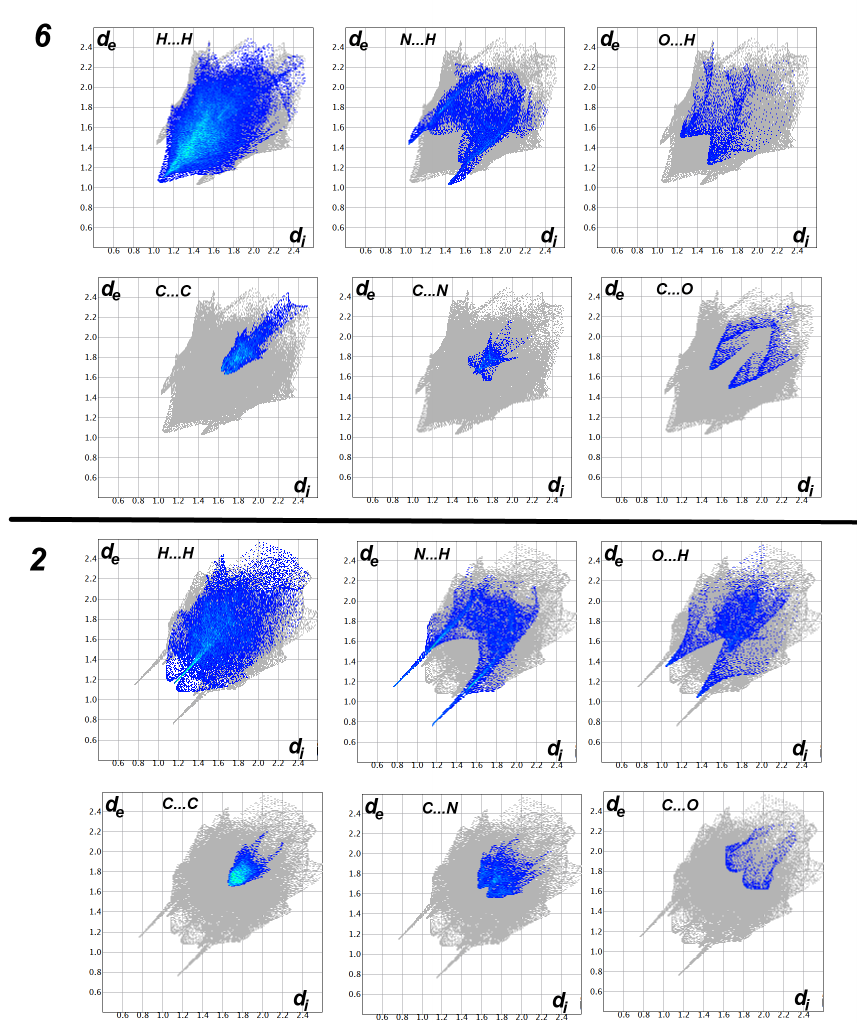
Figure 6. Decomposed fingerprint plots in compounds 2 and 6 .